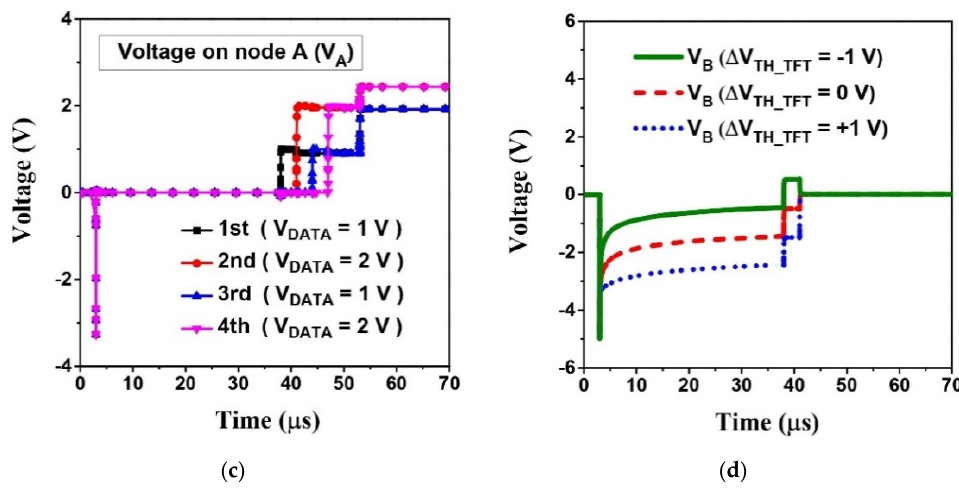
Figure 4. ( a ) Measured and simulated transfer curves of the a-IZTO TFT. ( b ) Transient waveforms of V A with first to fourth rows in different V DATA . ( c ) Transient waveforms of V A with V DATA = 1 V for Row1 and Row3, V DATA = 3V for Row2 and Row4. ( d ) Transient waveforms of V B of the proposed pixel circuit with ±1 V variation in V TH_TFT .